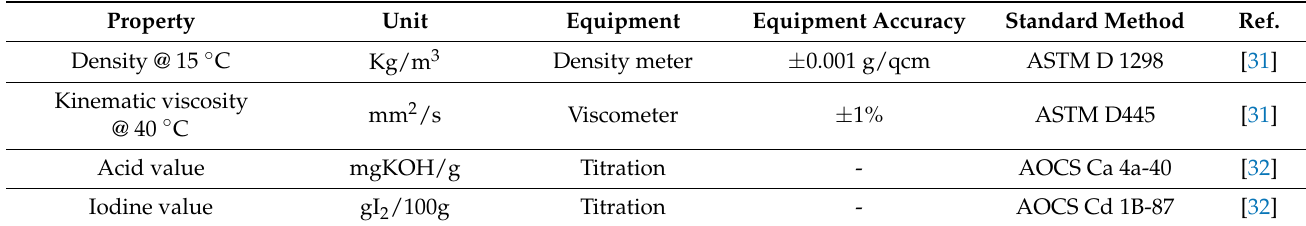
Table 3. Standard methods and equipment for properties